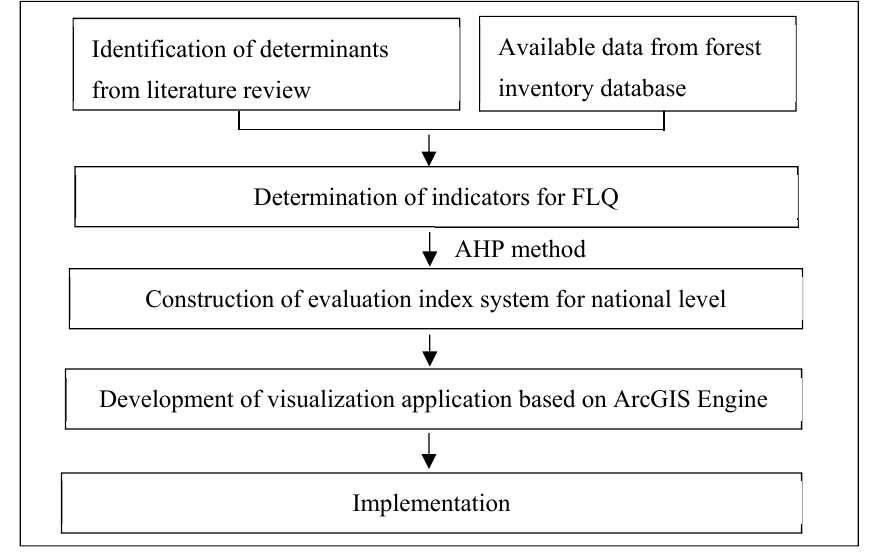
Figure 1. Research design of this paper.